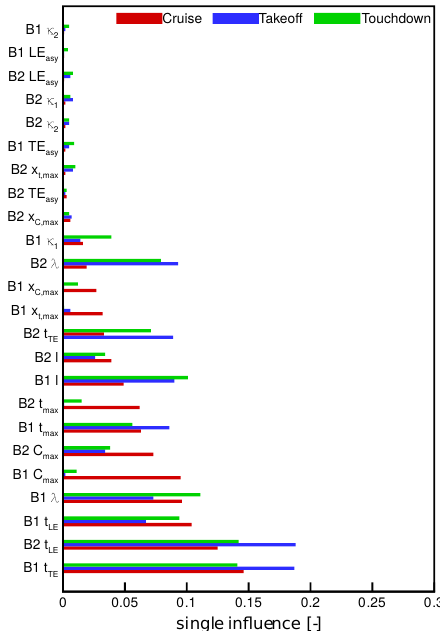
Figure 7. Pareto chart of loss coefficient ζ of blade 1 for all three operating